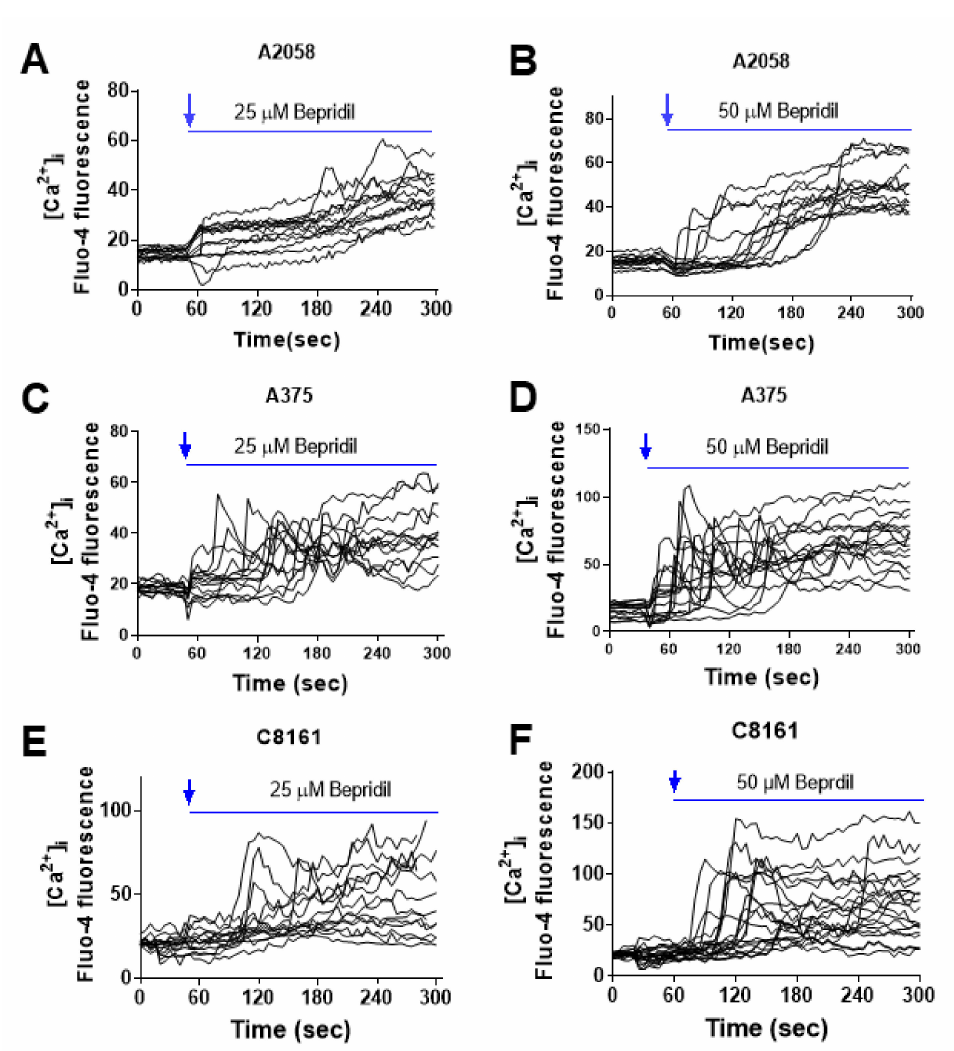
Figure 2. Effect of the NCX blocker bepridil on the level of cytosolic Ca 2+ ([Ca 2+ ] i ) measured by Ca 2+ imaging assay. ( A , B ) Flua-4 AM loaded A2058 melanoma cells were imaged and